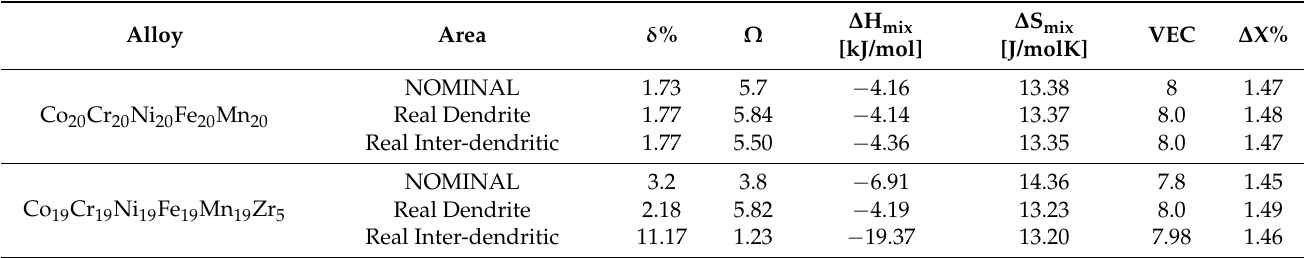
Table 4. Calculated parameters of the studied HEAs.